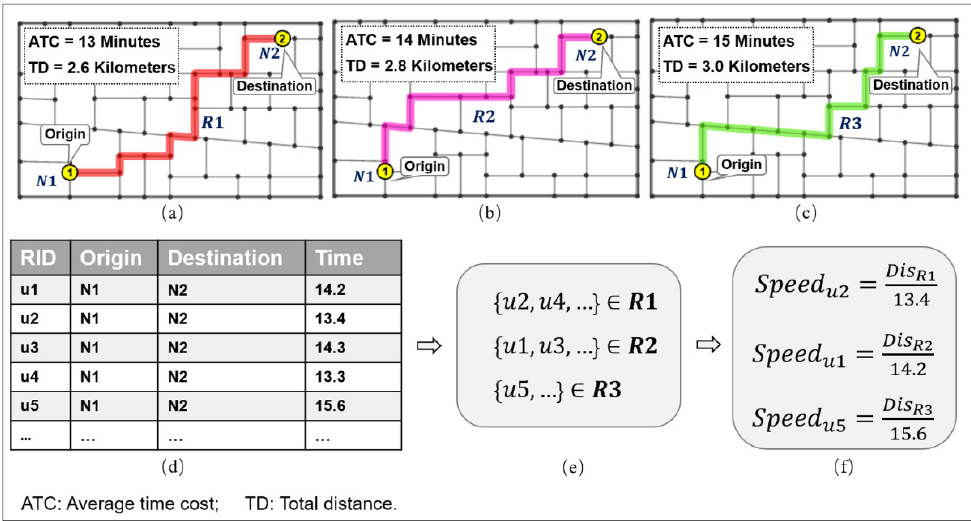
Figure 2. Online map-based riding path inference method. ( a ) Scheme I; ( b ) Scheme II; and ( c ) Scheme III of path planning; ( d ) riding records of origin, destination, and cost time; ( e ) matching result of riding record and path; ( f ) speed calculation of each riding record.